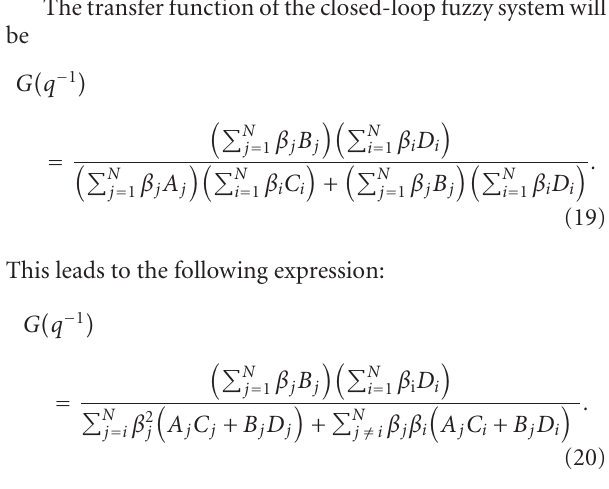
The transfer function of the closed-loop fuzzy system